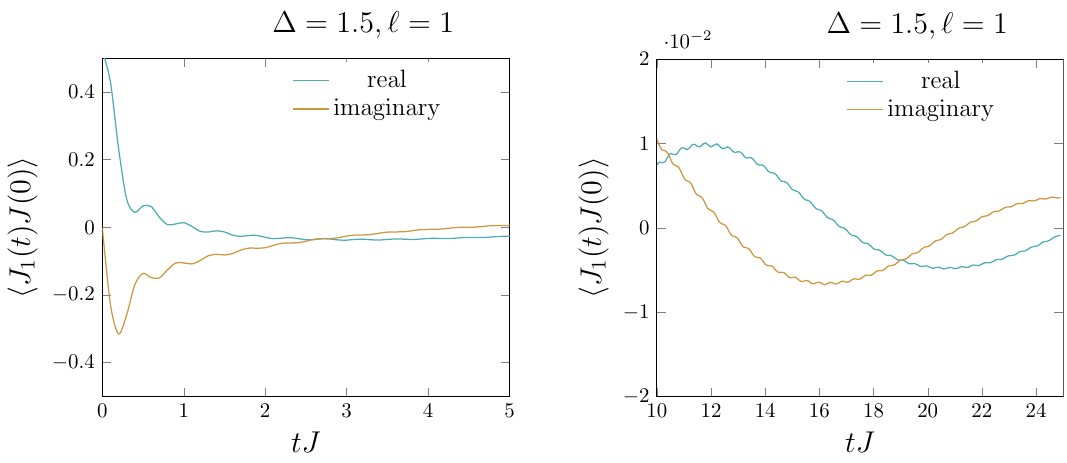
( t ) J (cid:11) for ∆ = 1.5 and times 0 < tJ < 5 (left), 10 < tJ < 24 (right). We Figure 3: 〈 J 1 = used L c